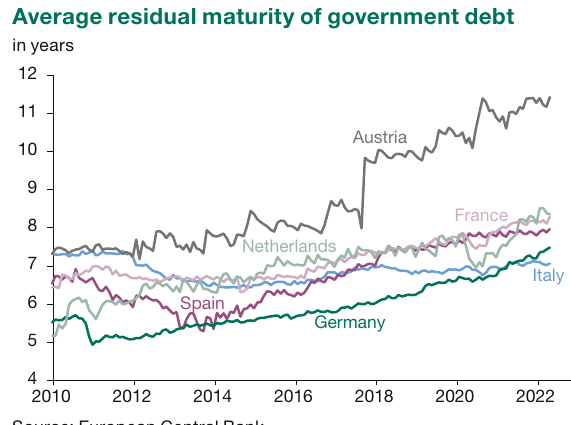
General government gross debt